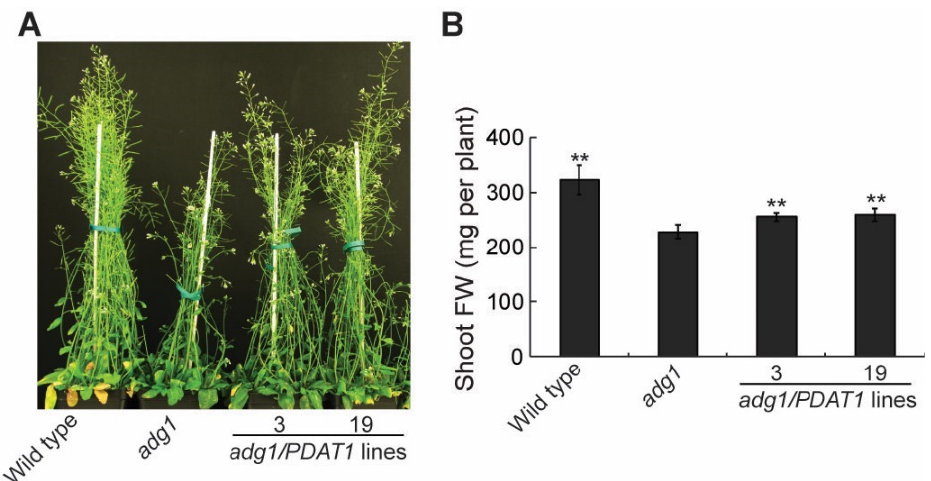
Figure 1. Overexpression of PDAT1 improves the growth of adg1 . ( A ) Six-week-old plants grown on soil under long days. ( B ) Shoot biomass of six-week-old plants grown on soil. Asterisks indicate statistically significant differences from adg1 based on Student’s t test ( P < 0.01).